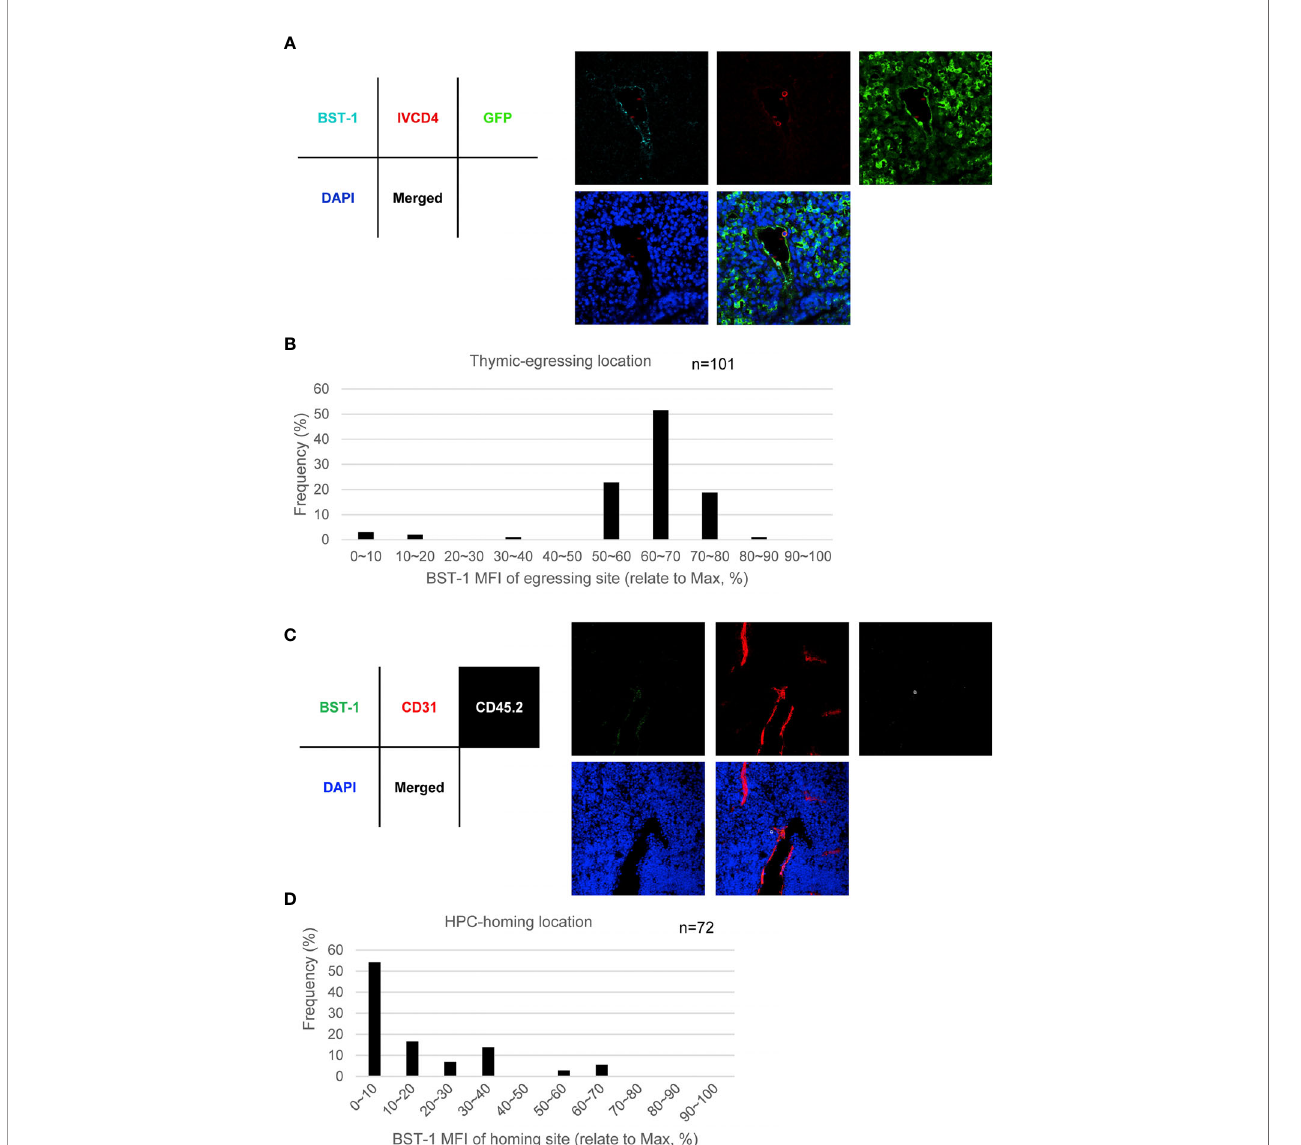
FIGURE 7 | BST-1 hi TPECs function as the exit sites for mature thymocytes, while BST-1 lo/ − TPECs serve as the entry sites for HPCs. (A, B) Egressing CD4 + T cells are mainly associated with BST-1 hi vessels. (A) Representative photo of egressing CD4 + T cells locate at BST-1 hi vessel. (B) Location distribution of egressing CD4 + T cells in relative to BST-1 MFI of the vessels. Totally 101 egressing CD4 + T cells were collected and calculated. (C, D) Thymic-settling HPCs are mainly associated with BST-1 lo/ − vessels. (C) Representative photo of homing HPCs locate at BST-1 lo/ − vessels. (D) Location distribution of settling HPCs in relation to BST-1 MFI of the vessels. Totally 72 settling HPCs were collected and